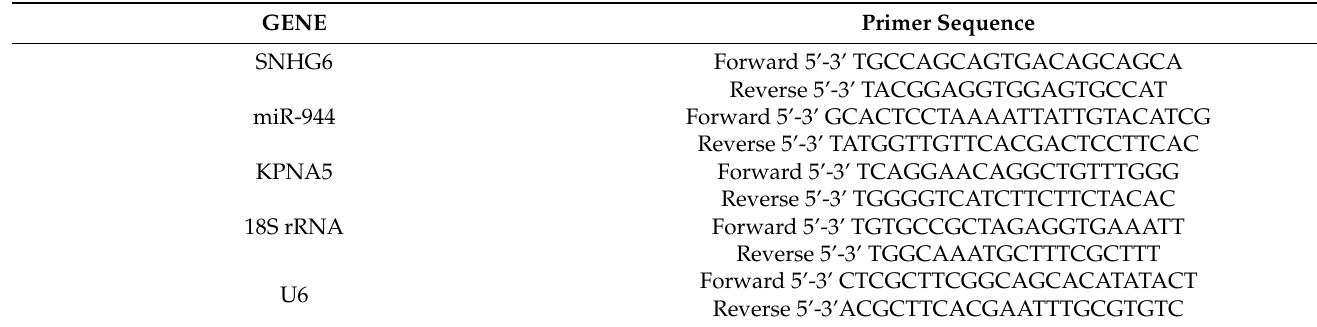
Table 1. List of primers for real-time